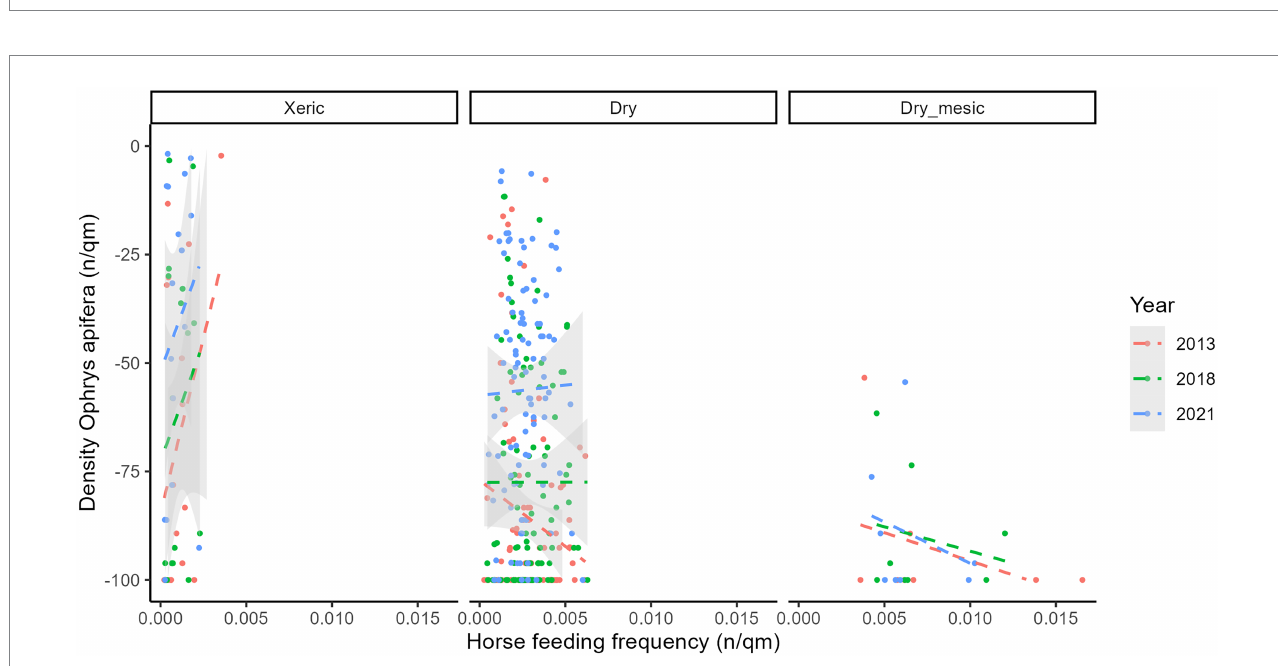
FIGURE 8 Effect of horse feeding frequency on inverse-transformed density of Ophrys apifera in the different calcareous grassland types in 2013, 2018 and 2021 ( n = 121; xeric n = 17, dry n = 96, dry-mesic n = 8). Shaded area represents 95% confidence